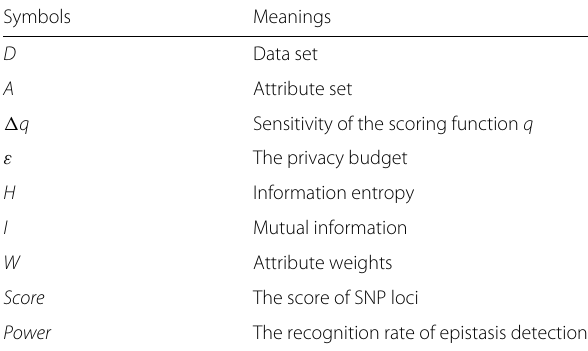
Table 1 Main symbols and their